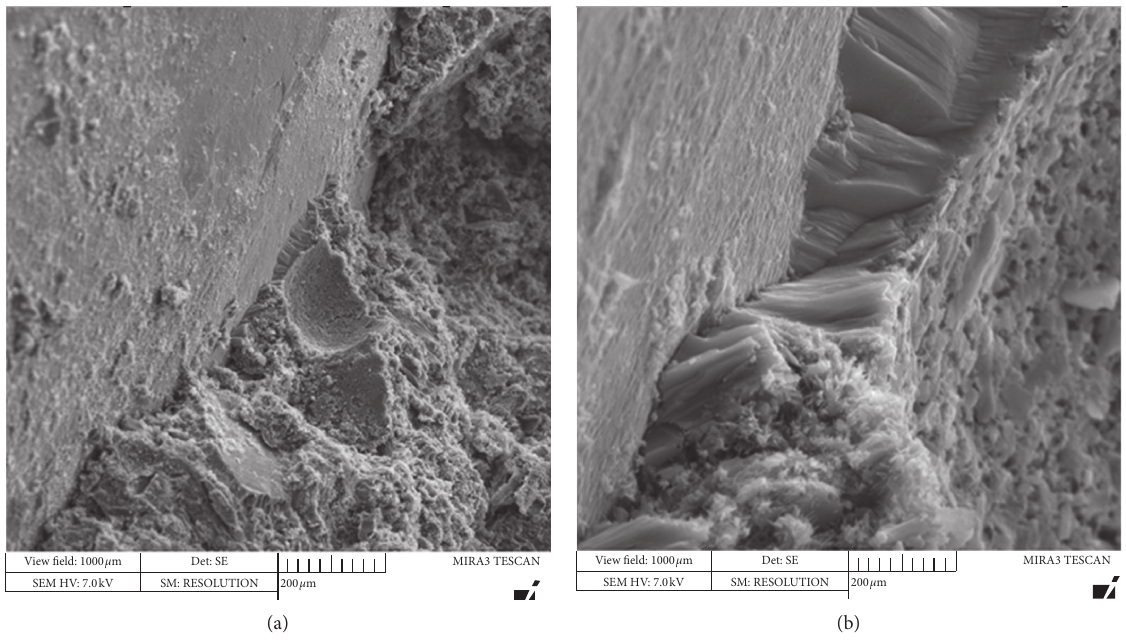
Figure 15: Microstructure of the cleavage surface of a composite based on a modified shot of titanium hydride, subjected to c -irradiation at a dose of D � 2 MGy (SEM): (a) 2500x magnification; (b) 25000x magnification.